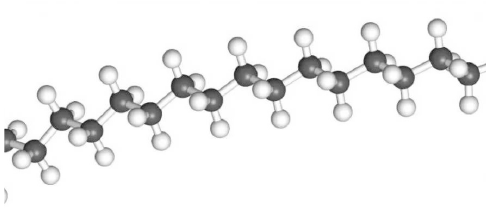
Figure 1. The molecular structure of polyethylene